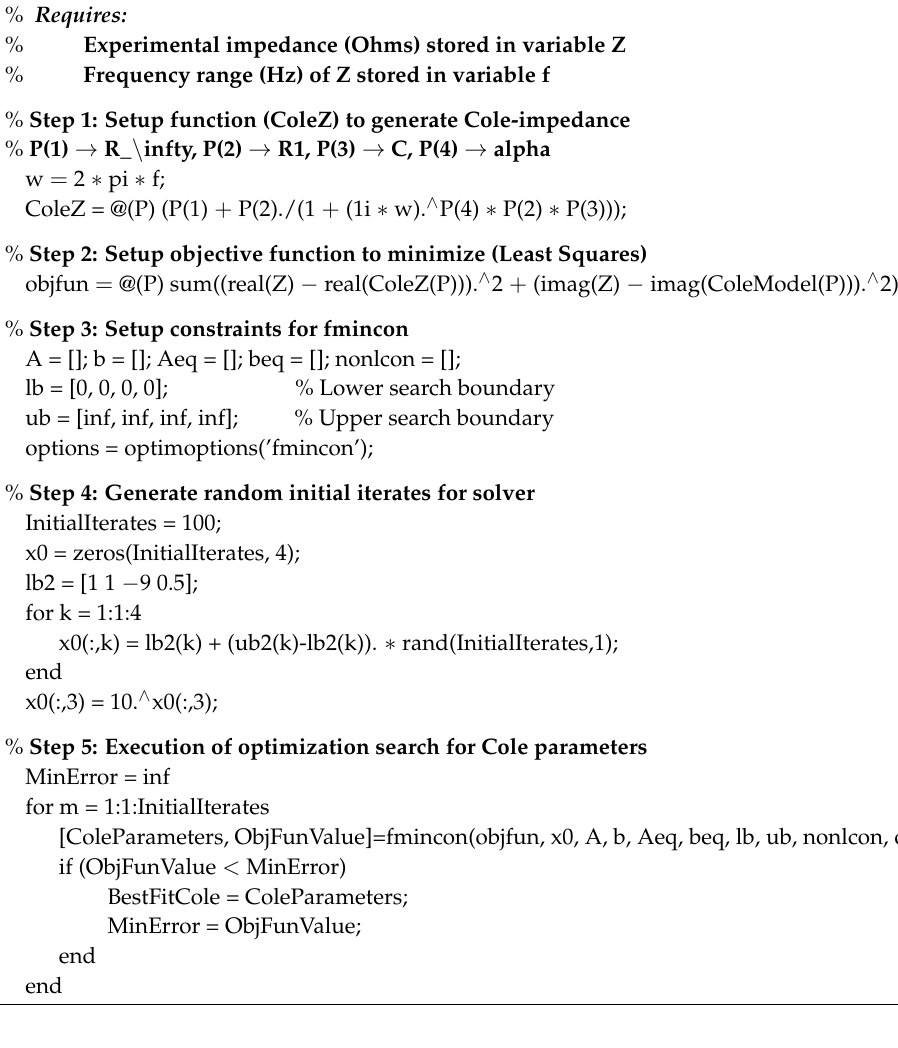
Algorithm 1 Sample MATLAB Code to Extract Cole-Impedance Parameters from Experimental Impedance